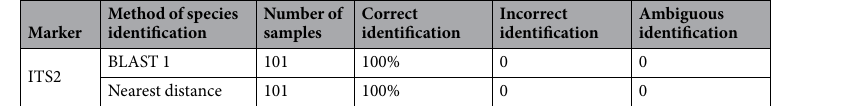
Table 3. The identification efficiency of the ITS2 sequences using different methods.